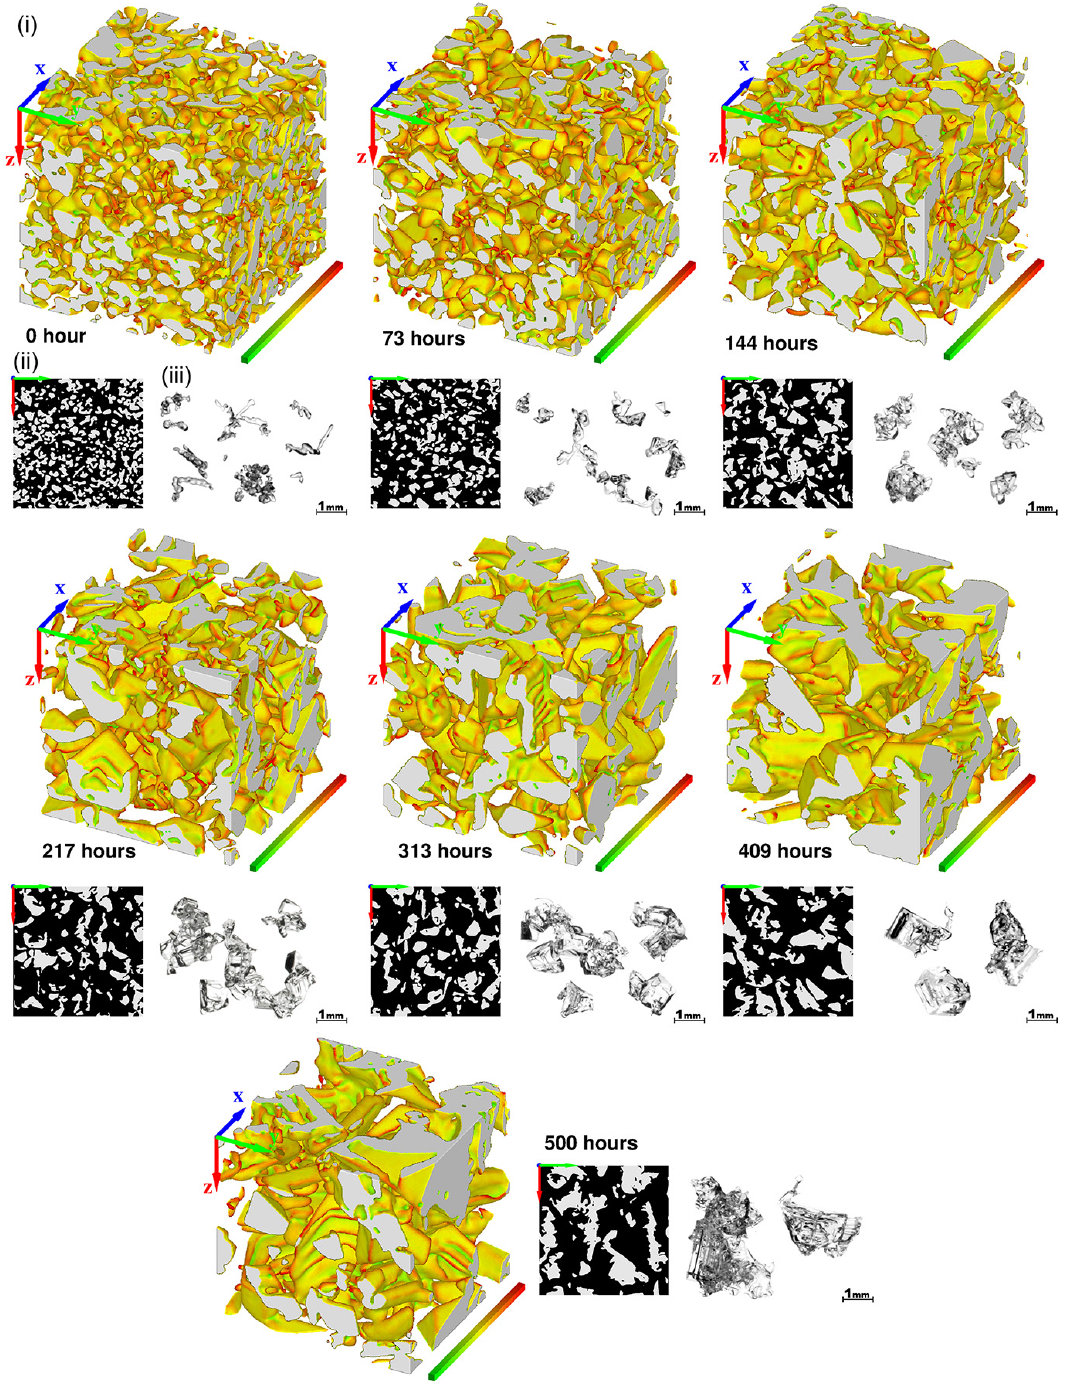
Figure 5. Microstructure evolution during the TG metamorphism. For each stage of the evolution, the following views are given: (i) 3-D images of the snow samples where colors represent the mean curvature of the surfaces, ranging from − 36 to + 36mm − 1 . Convexities, flat shapes and concavities are shown in red, yellow and green, respectively. Images have a size of 3mm × 3mm × 3mm. For a better visualization of the faceted shapes, the images are presented “upside down”. The arrows in blue, green and red correspond to the x , y and z directions of the images, respectively. (ii) Vertical cross sections from 3-D images of 5.5mm × 5.5mm × 5.5mm, where ice is in white and air in black. (iii) Photographs of snow